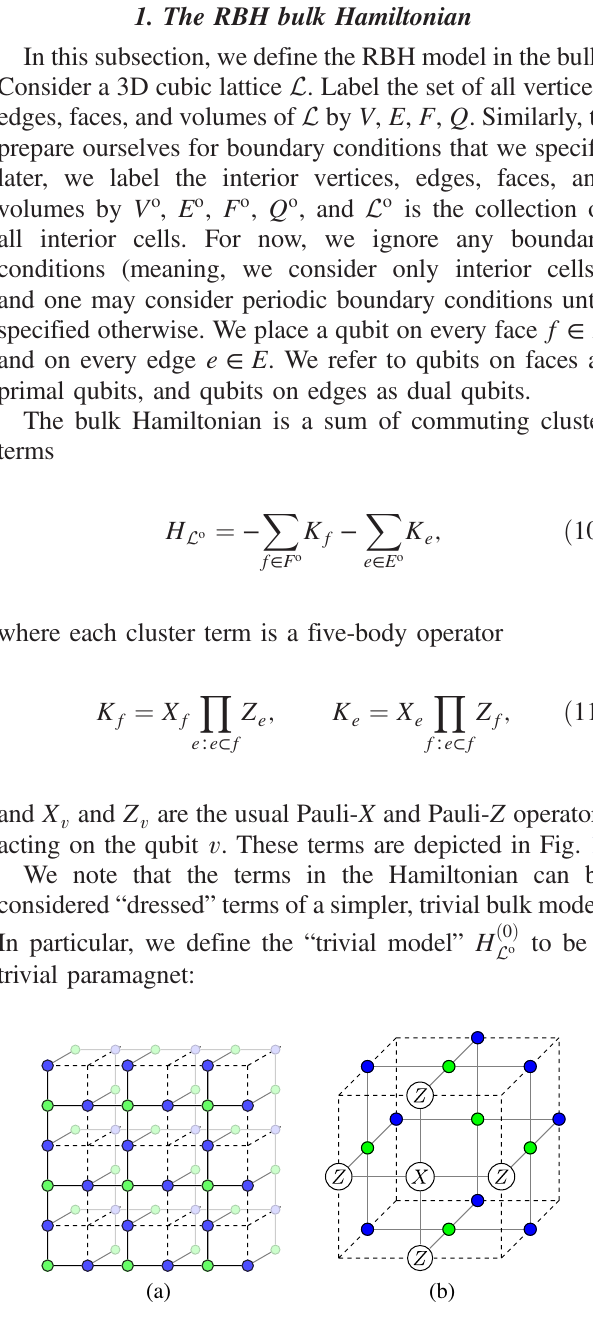
FIG. 1. (a) A portion of the bulk lattice. Primal qubits are depicted in green, while dual qubits are depicted in blue. (b) A bulk cluster term K . In both figures, bold lines indicate nearest- f neighbor relations between qubits, while dashed lines indicate edges of the ambient cubic